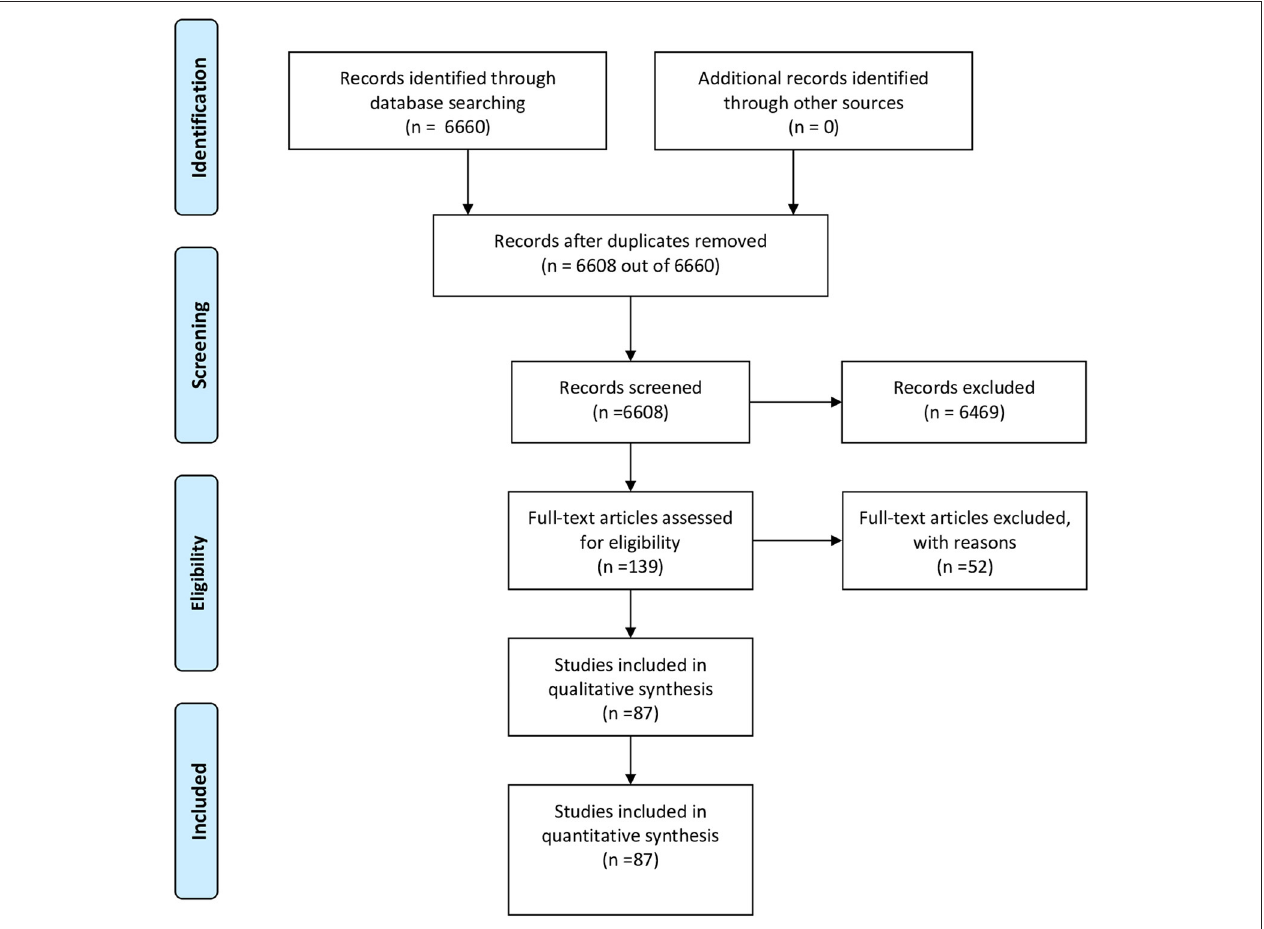
FIGURE 1 | Study Flow